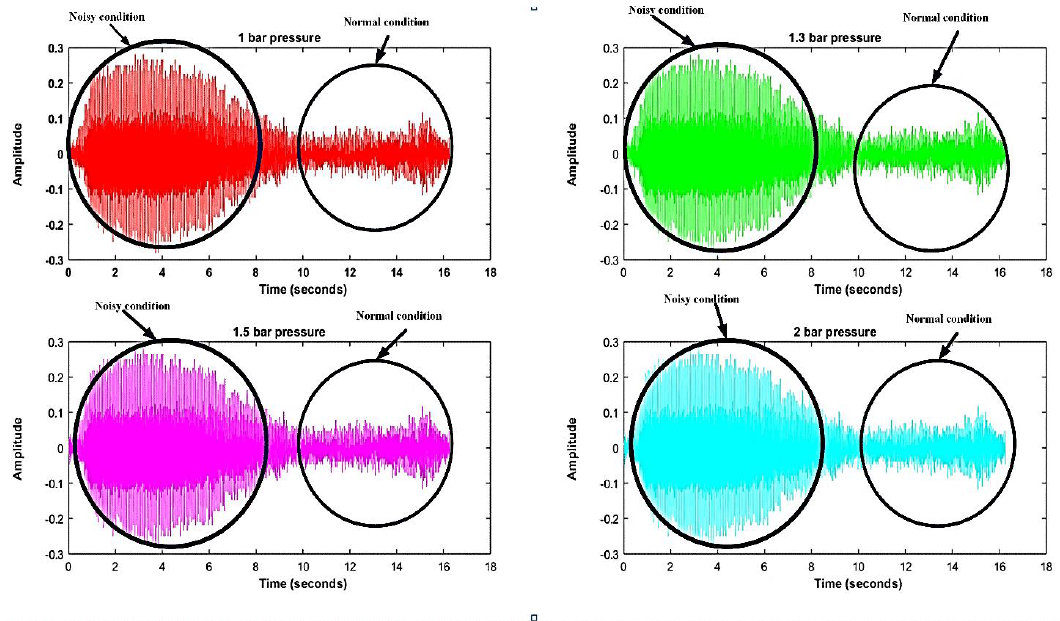
Figure 12. Analysis of noisy and typical frequency spectrum in the time domain in various pressure bar (regression analysis). Table 5. Vibration analysis result .